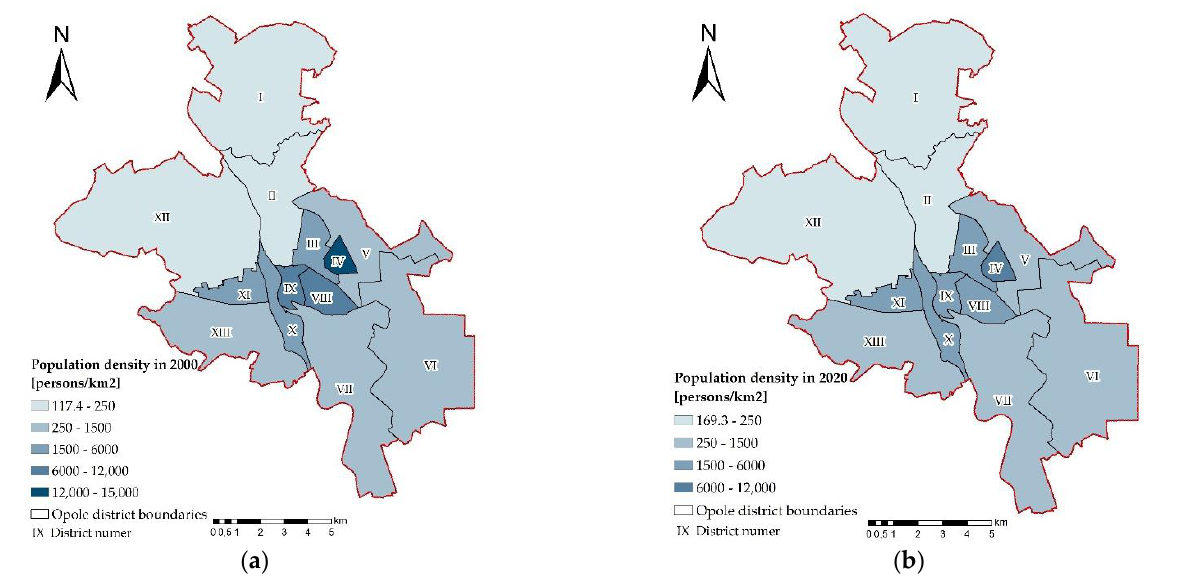
Figure 4. Changes in population density in Opole’s districts: ( a ) in 2000, ( b ) in 2020. A significant decline in population was also recorded in district XI, which, like district IV, is a large residential area. In 2020, districts I and XII, both located in the northern and north-western part of Opole, at a considerable distance from the centre, had still the lowest population density, but with positive growth dynamics in relation to the reference year 2000. The highest population density, ca. 11,000 people/km 2 , is still found in district IV located in the city centre (Figure 4). However, in comparison with 2000, this district experienced the largest population outflow.